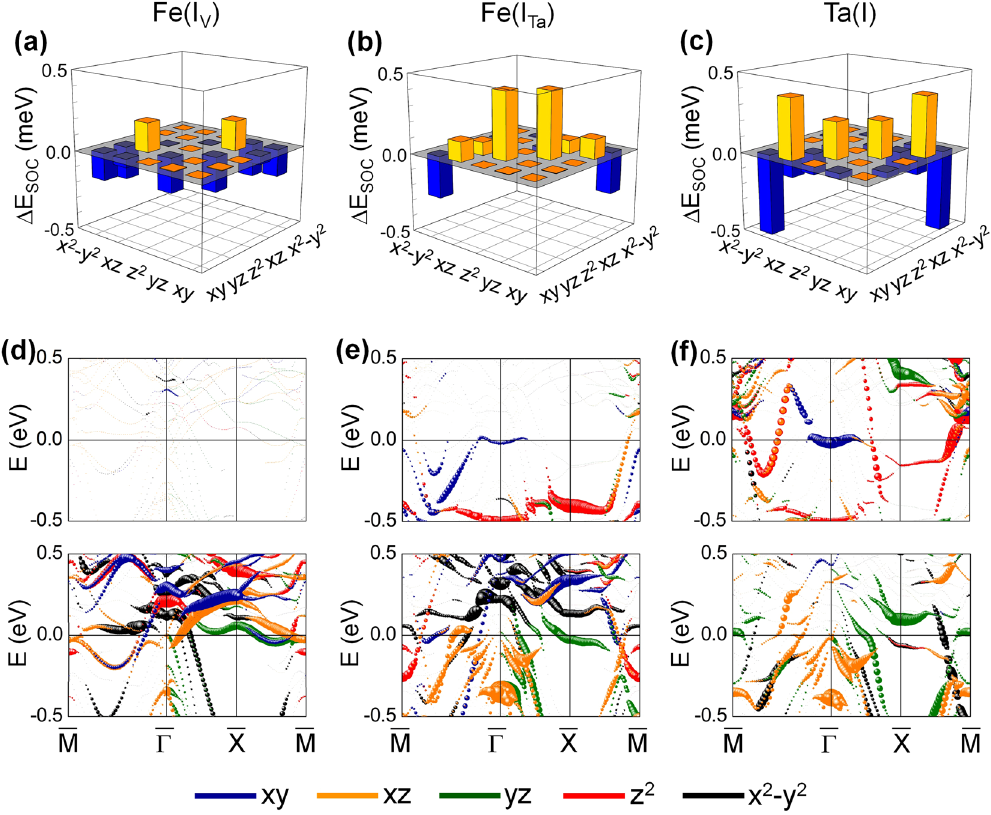
Figure 6. The d -orbital matrix decomposed Δ E soc of ( a ) Fe(I V ) for FeRh/MgO and ( b ) Fe(I Ta ) and ( c ) Ta(I) for Ta/FeRh/MgO multilayers. ( d – f ) The corresponding d -orbital projected band structures in the majority-spin (top panels) and minority-spin (bottom panels) states. The d xy , d xz , d yz , d z2 , and d x2 − y2 orbital states are shown in blue, orange, green, red, and black symbols, respectively. The sizes of the symbols represent the weights of the d -orbital states. The Fermi level is set to zero